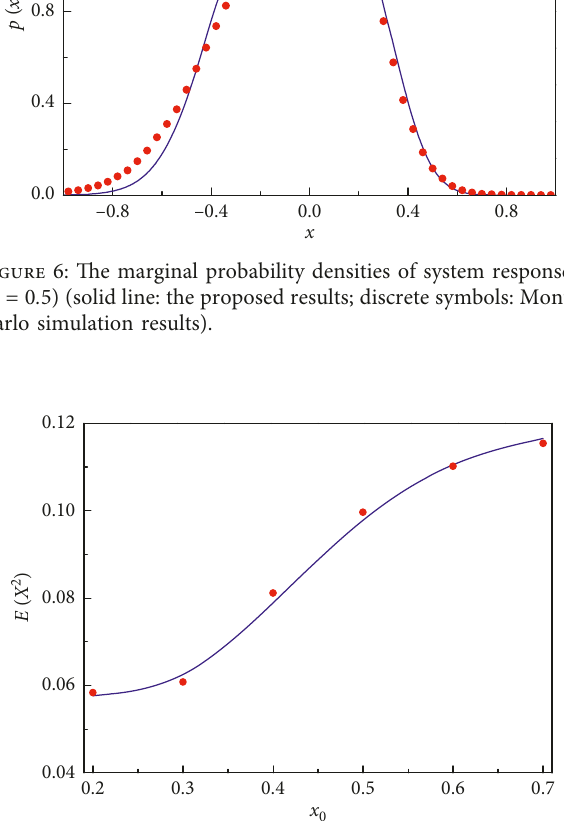
Figure 7: The relations of mean square responses E [ X 2 ] to the limit of elastic deformation x (solid line: the proposed technique; 0 discrete symbols: Monte Carlo simulation